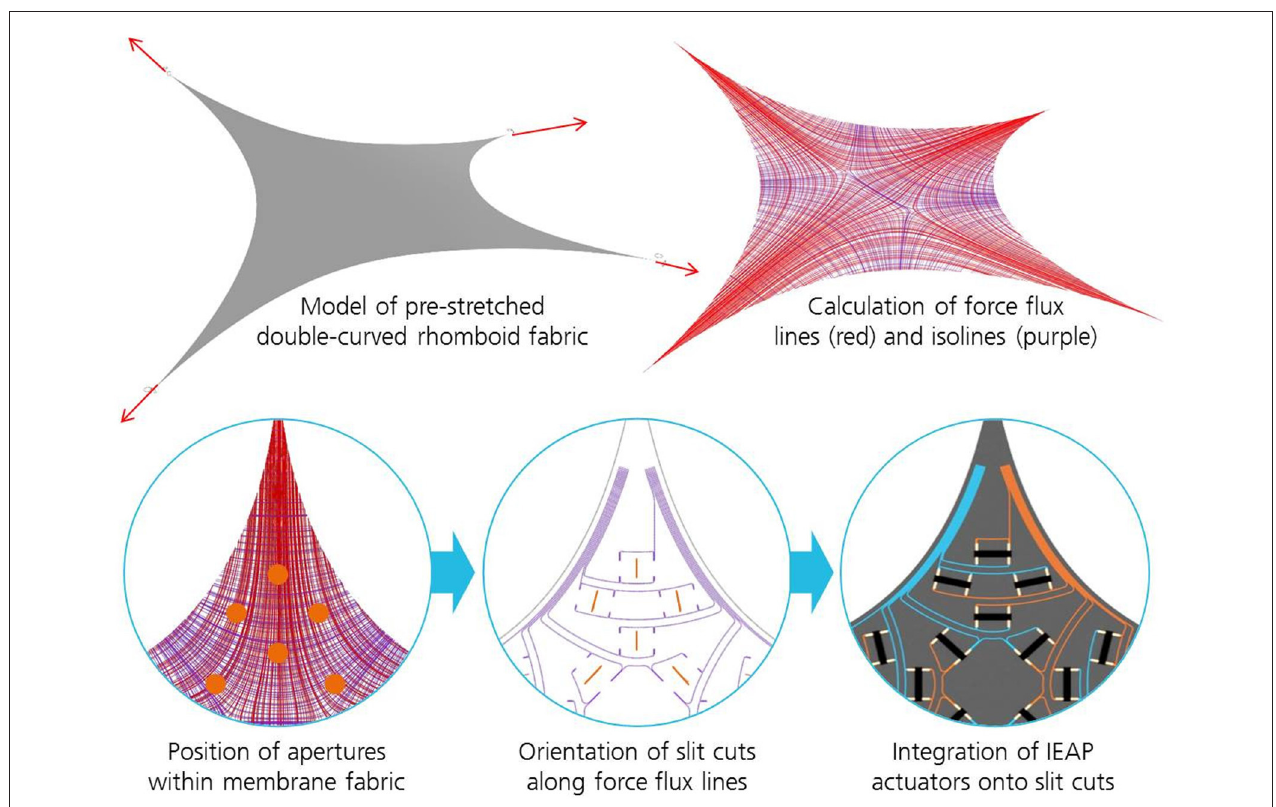
FIGURE 7 | Methodical approach toward optimized positioning and orientation of actuated slit cuts and integration of stretch-resistant conductive